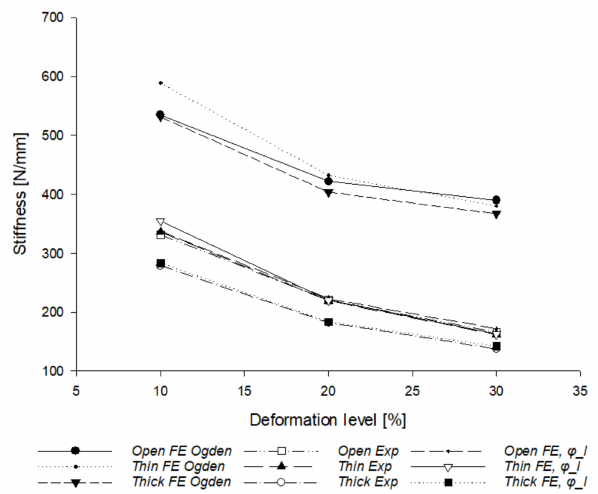
Figure 14. Experimental results and FE simulation results with the Ogden model.